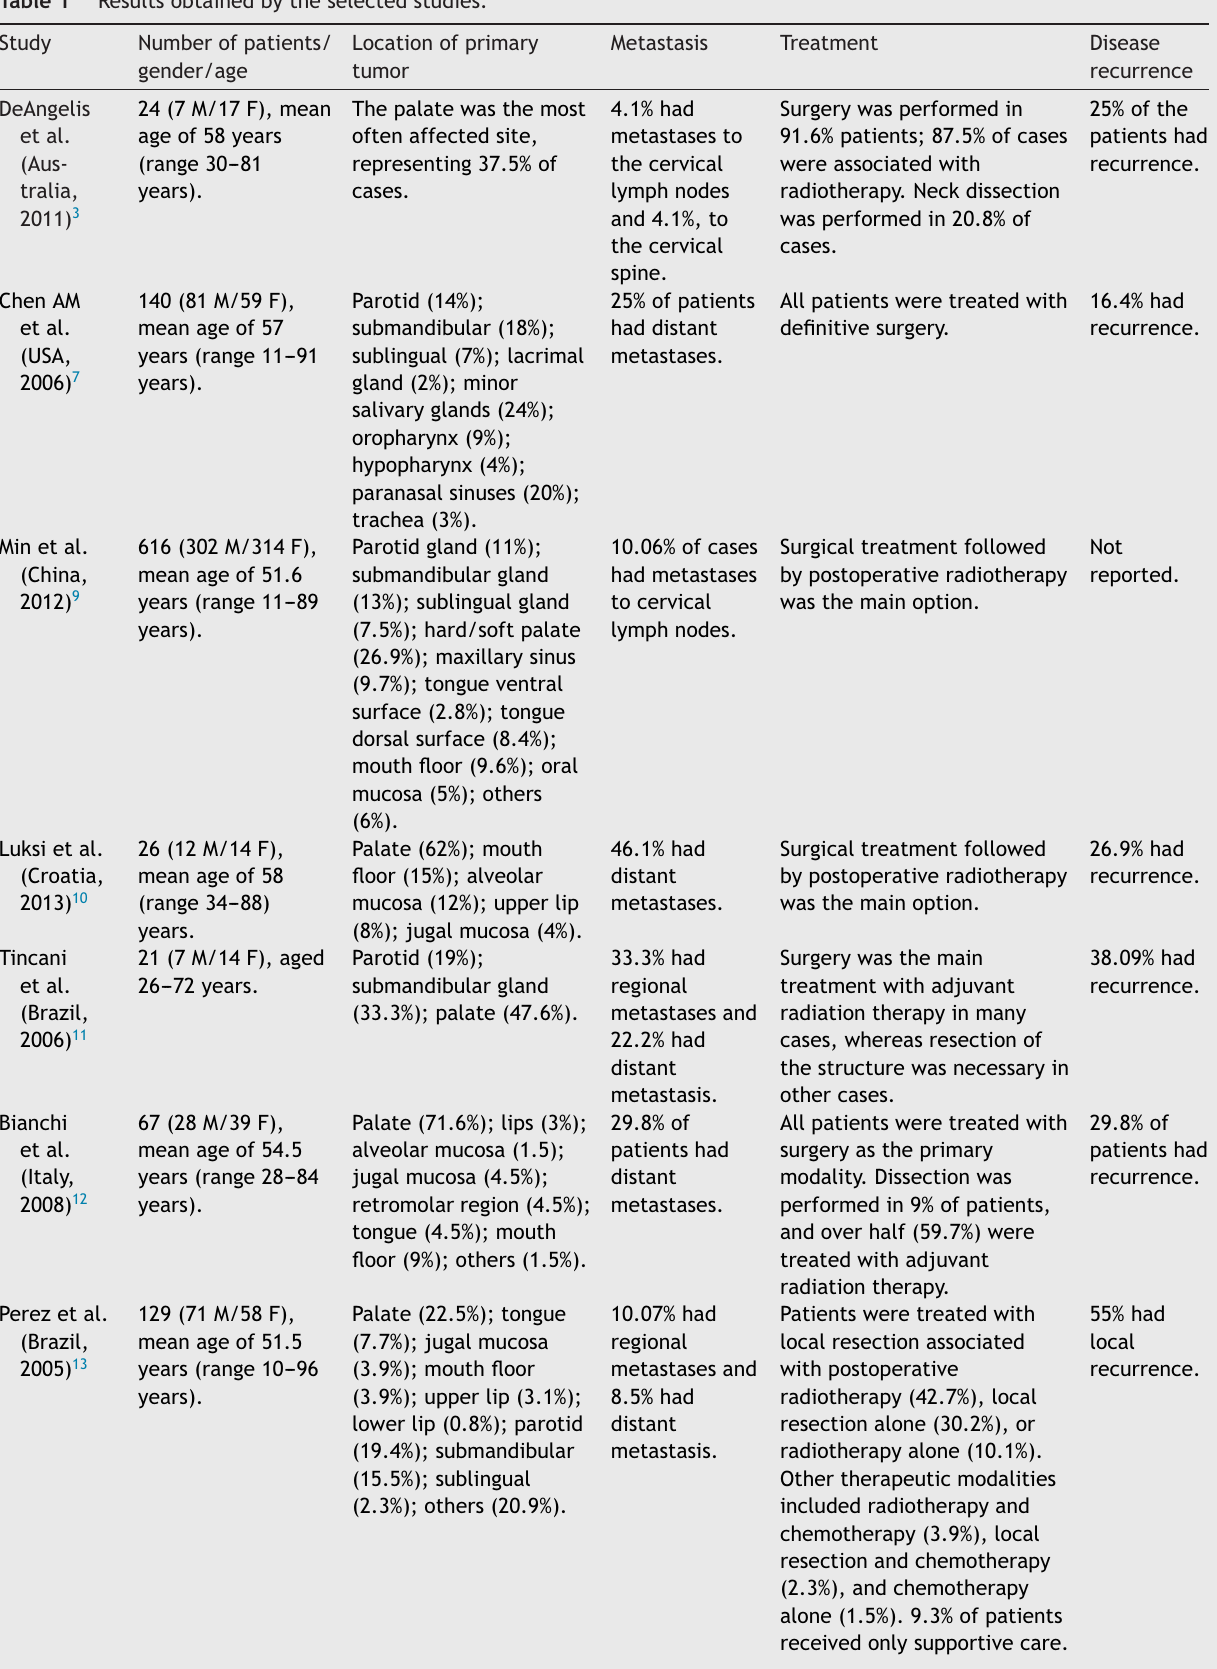
Results obtained by the selected